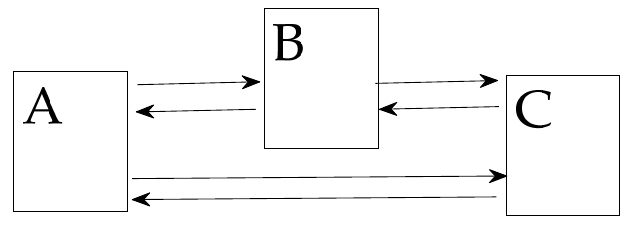
Figure 2. Diagram of the object modeled.